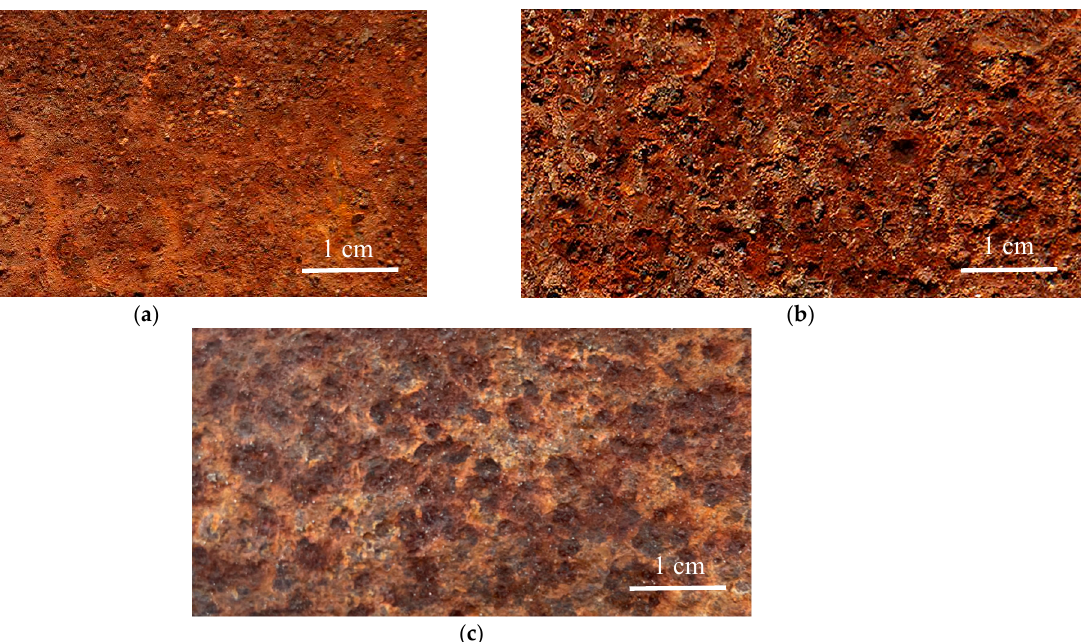
Figure 3. Surface morphology of the rust layers at different atmospheric exposure times: ( a ) 12 months of urban industrial atmospheric corrosion, ( b ) 48 months of urban industrial atmospheric corrosion, and ( c ) 84 months of urban industrial atmospheric corrosion.